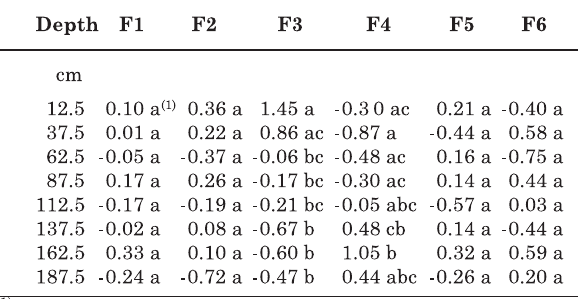
(1) Same letters mean no significant difference between